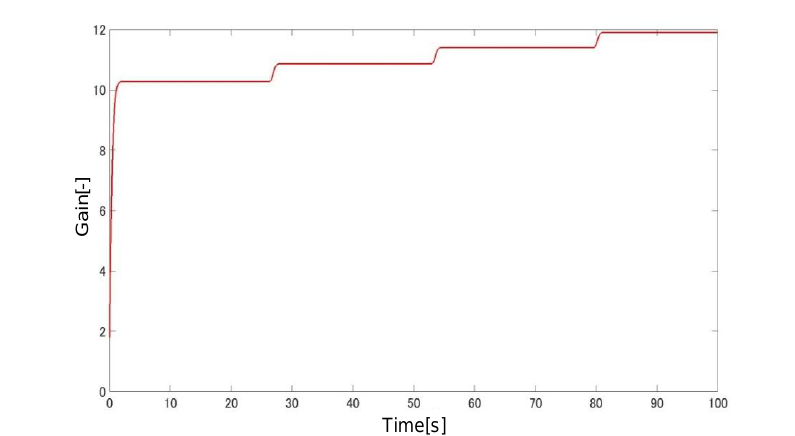
Figure 16. The gain of the previous method.